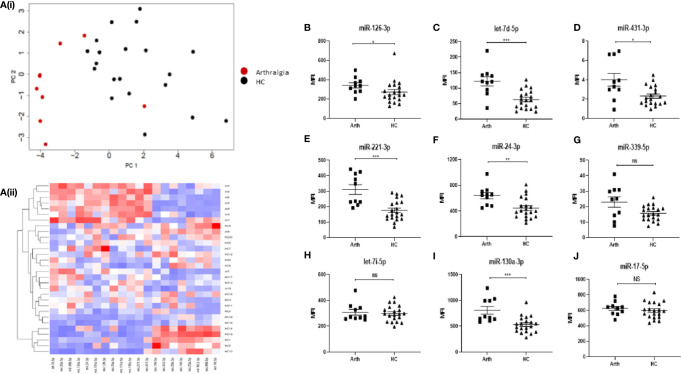

(A) Hierarchical clustering analysis of miRNA expression for the top 20 differentially expressed miRNAs between arthralgia and HC. (i) PCA plots and (ii) Heatmap depicting serum miRNA expression in 10 Arthralgia and 20 HC individuals. Analysis was performed in R (v4.0) using package Seurat (v3.2.3), function scale and package gplots (v3.1.1), function heatmap2. Distance matrix was generated by Euclidian distance measure and clustering performed with complete agglomeration. PCA analysis was performed in R (v4.0) function prcomp with scaling. (B–J) Expression of nine miRNAs of interest between arthralgia patients and HC individuals. miRNA expression was determined by Multiplex Circulating miRNA Assay. Graphs show MFI for arthralgia patients (N = 10) and HC individuals (N = 20), represented as mean ± SEM. ***p ≤ 0.001, **p ≤ 0.01, *p ≤ 0.01 and NS, not significant as determined by Mann-Whitney U test.